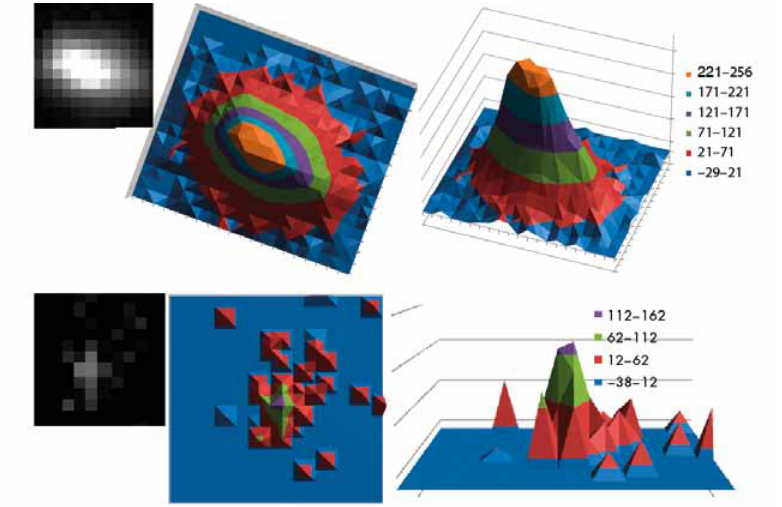
Fig. 2. Image analysis for a bright and a weak